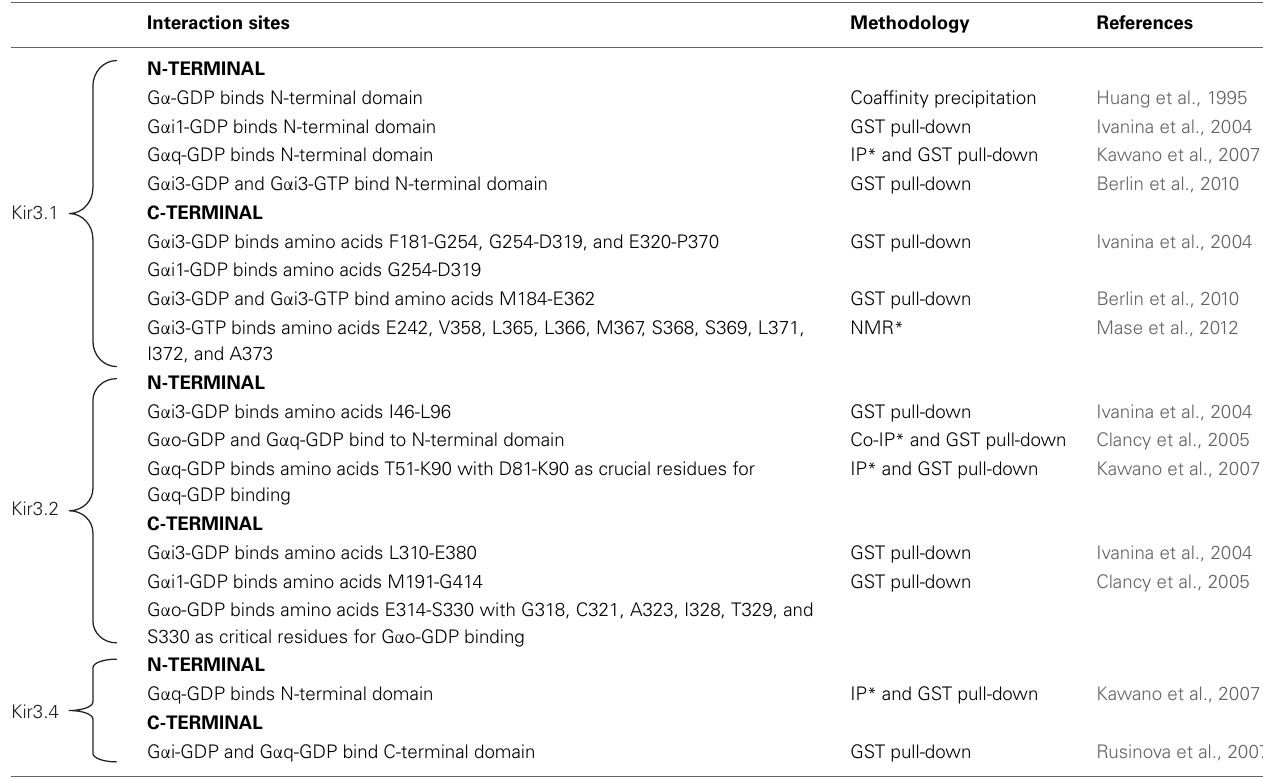
Table 2 | G α interaction sites on different Kir3